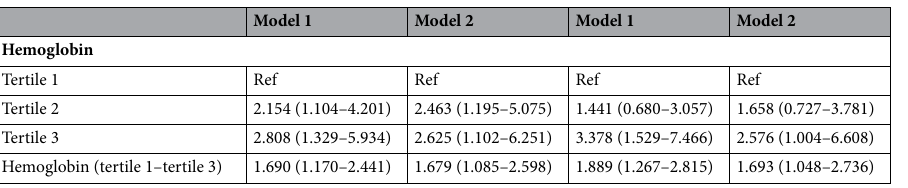
Table 3. Multinomial logistic regression of associations between hemoglobin and EPVS degree predominance patterns. The base outcome for all analyses is the BG-EPVS > CS-EPVS pattern. Model 1: unadjusted model. Model 2: adjusted for age and sex. BG basal ganglia, CS centrum semiovale, EPVS enlarged perivascular spaces, OR odds ratio, CI confidence